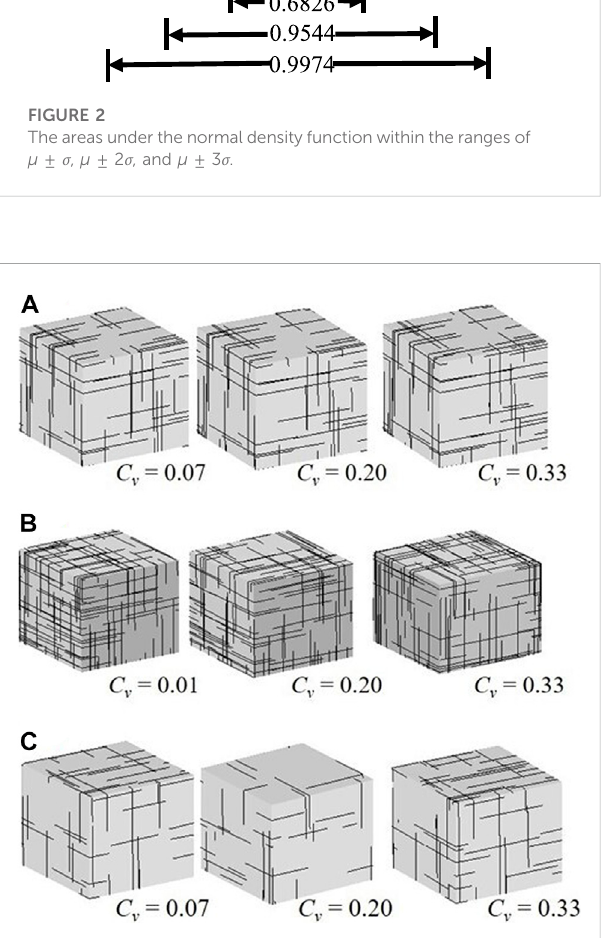
The fracture networks with different dispersions of fracture size: (A) model II, (B) model III, (C) model Ⅴ ; the domain size of (A) to (C) is 3.6 × 3.6 × 3.6 m 3 , 18.2 × 18.2 × 18.2 m 3 , 2.6 × 2.6 × 2.6 m 3 .